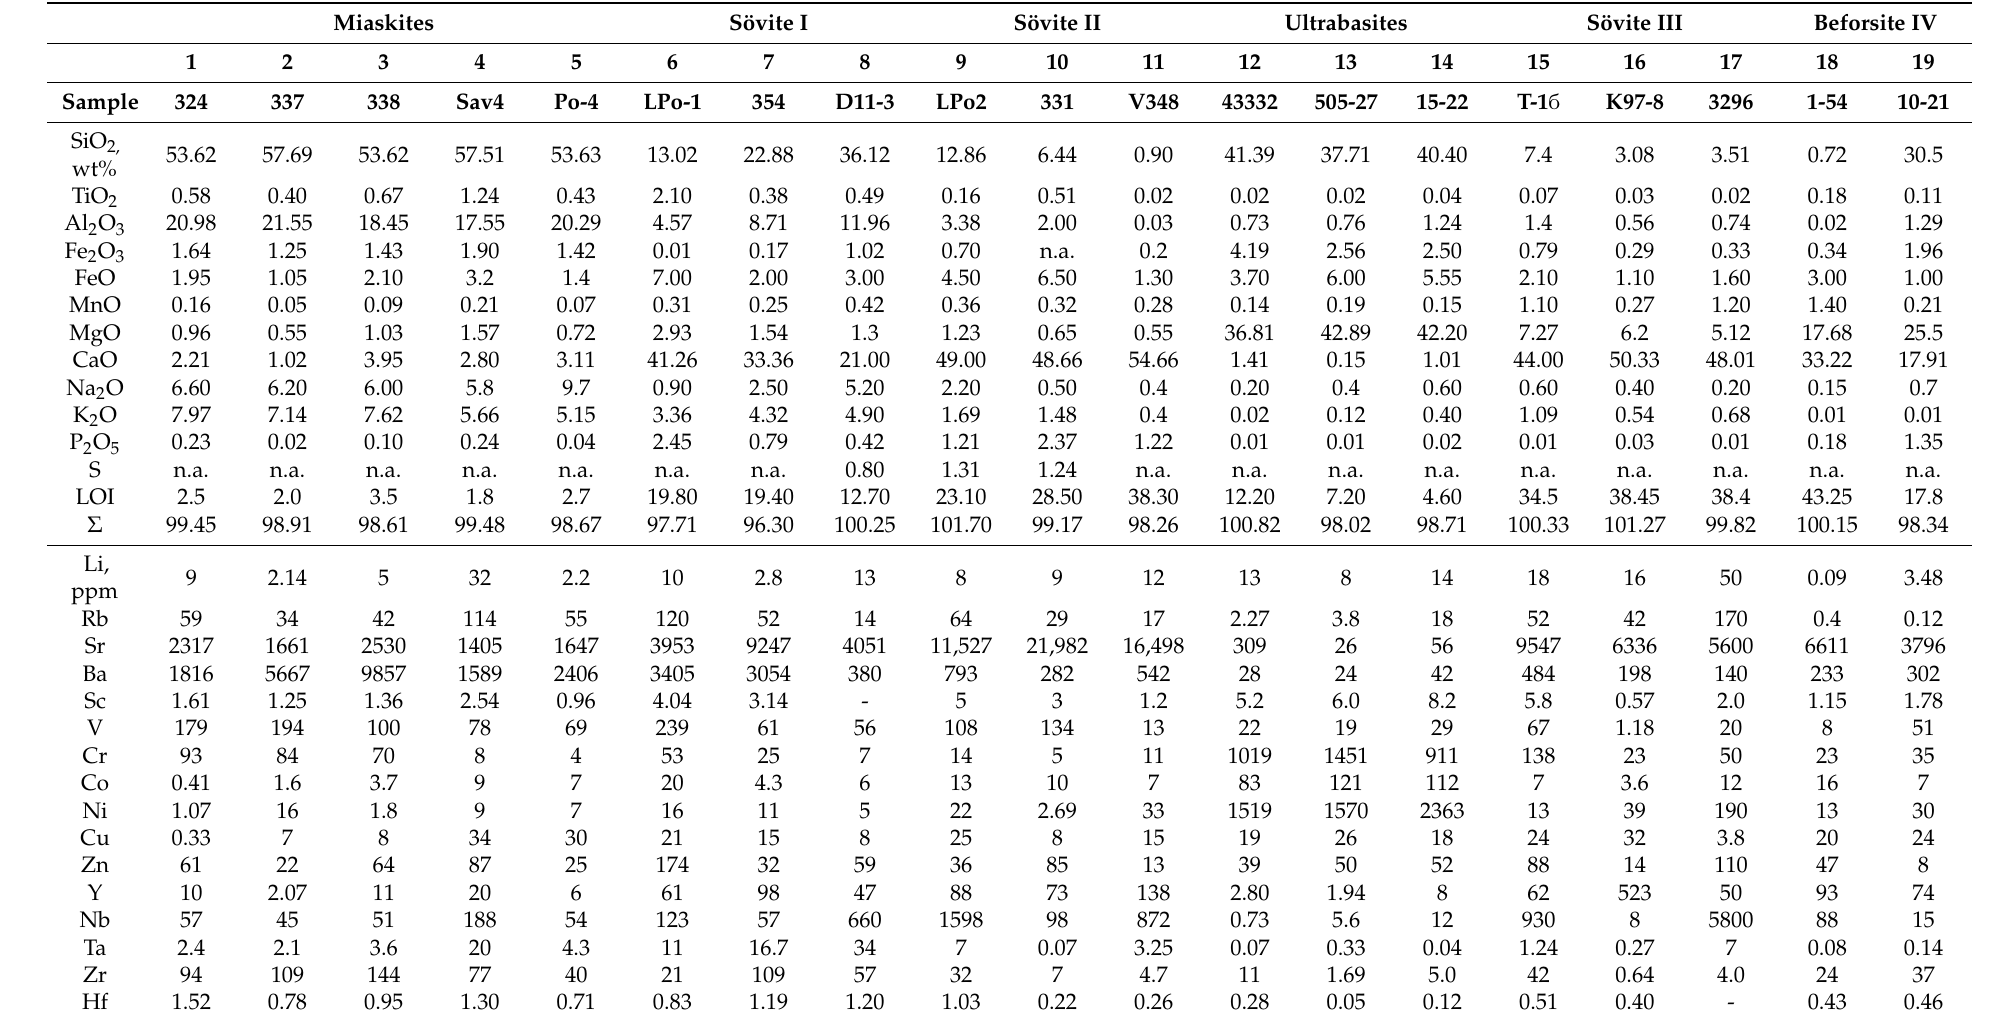
Table 3. Representative chemical composition of rocks from the IVC and Buldym carbonatite complexes, Southern